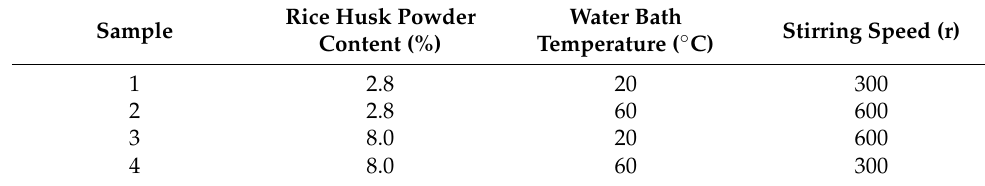
Table 3. Orthogonal test